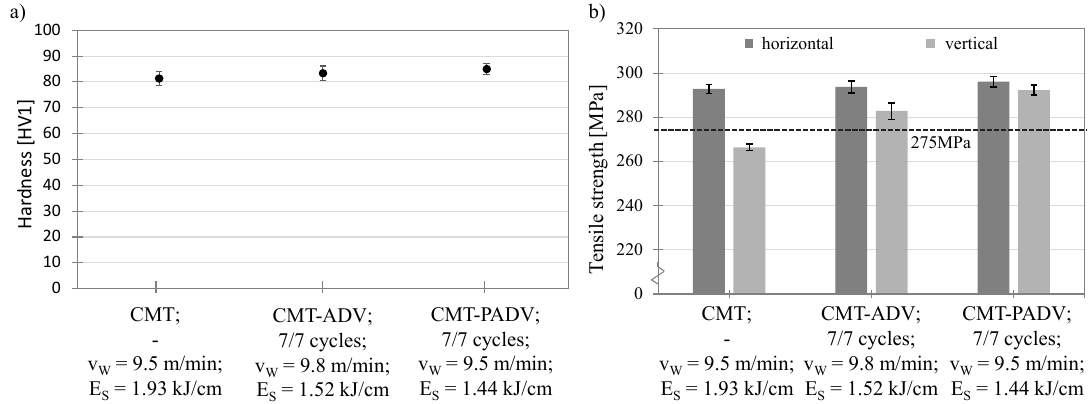
Figure 16. ( a ) Representation of the average hardness measured along the structure in the buildup direction as a function of the arc mode and ( b ) the representation of the tensile strength of the samples taken vertically and horizontally as a function of the arc mode and the manufacturer’s specification of the tensile strength of the pure weld metal (dashed line).